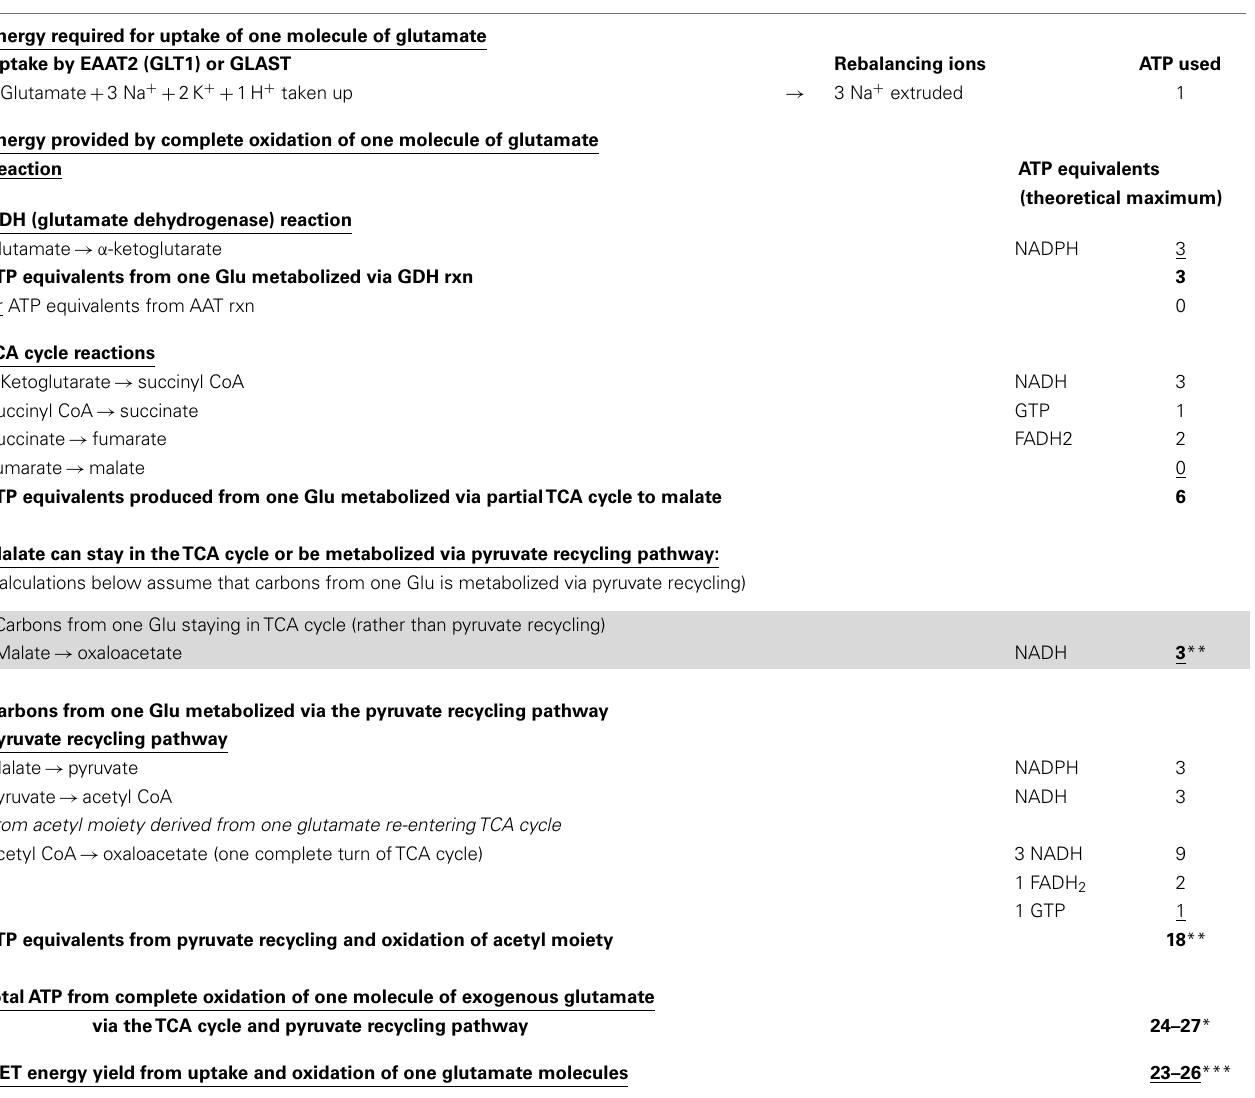
Table 1 | Energy produced in astrocytes from oxidation of one glutamate molecule in theTCA cycle and oxidation via the pyruvate recycling